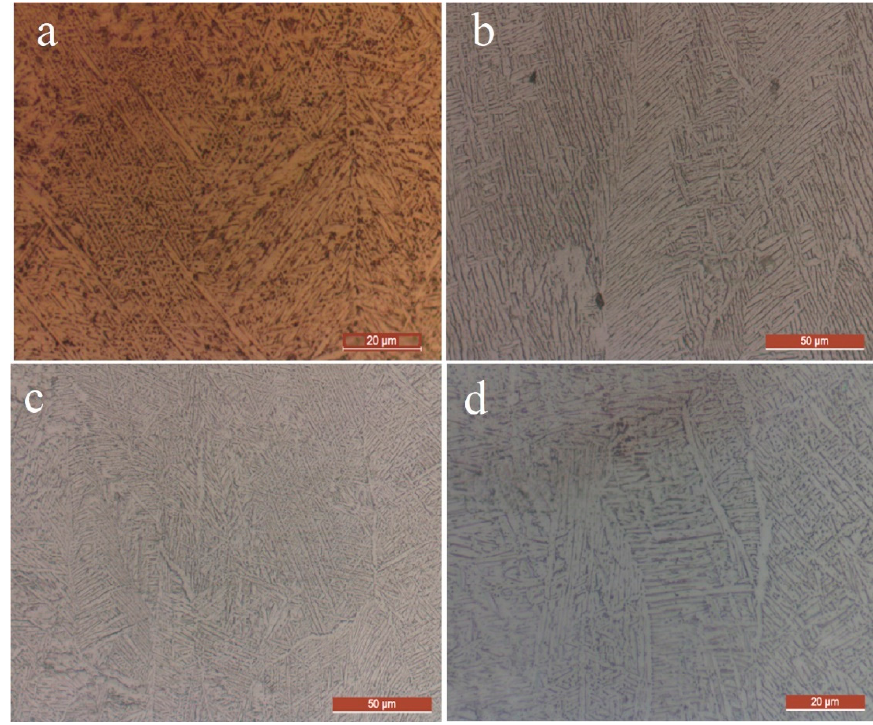
Figure 9. Optical images of microstructures in the core region for the a–d sample disks.